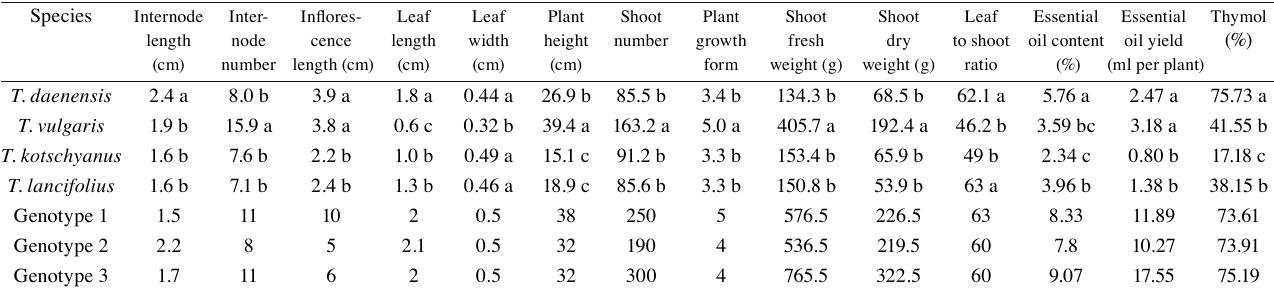
Tab. 9: Morphological and phytochemical traits of selected elite genotypes in comparison to different species. Species